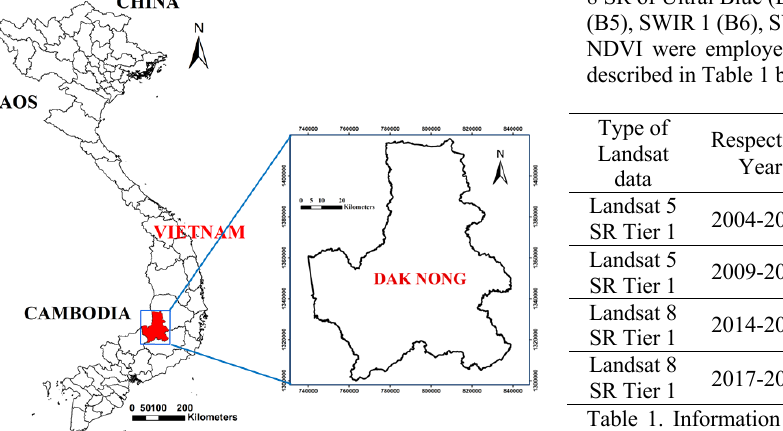
Figure 1. The location of the study